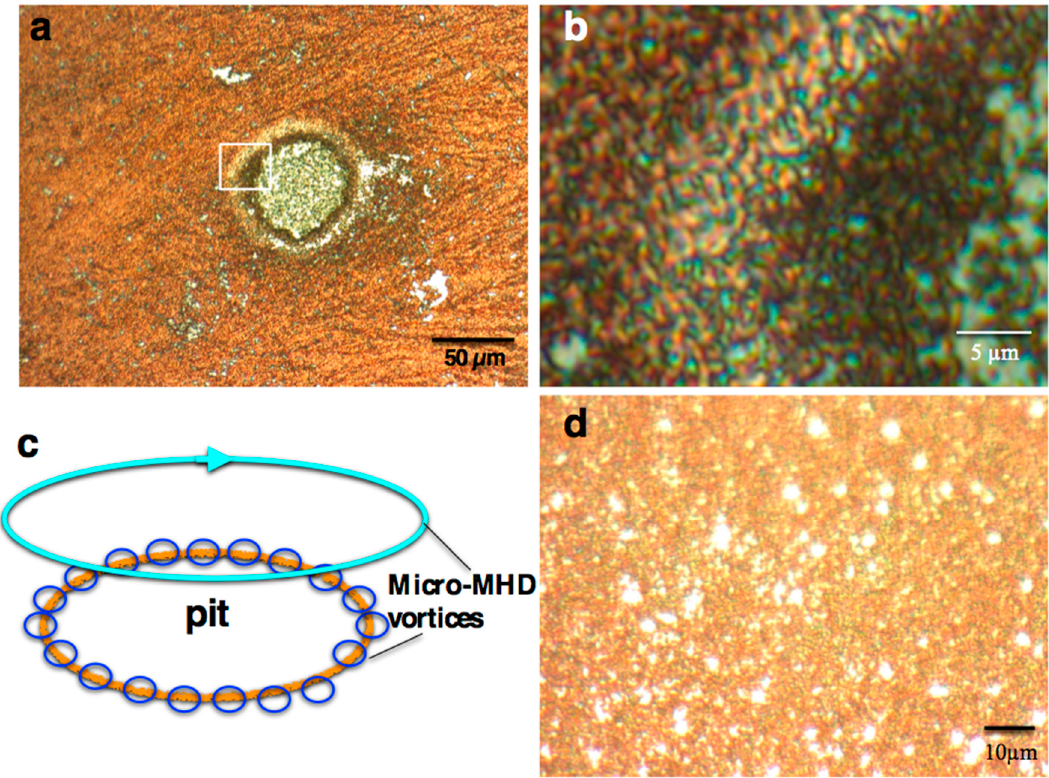
Figure 2. Microphotographs of MEE film surfaces prepared at a deposition current of 23 mA·cm − 2 . ( a ) +5T-film around a pit; ( b ) zoom-in photograph at the edge of pit (the rectangle part in ( a )); ( c ) schematic of multi-scale micro-MHD vortices around a pit; ( d ) 0T-film.